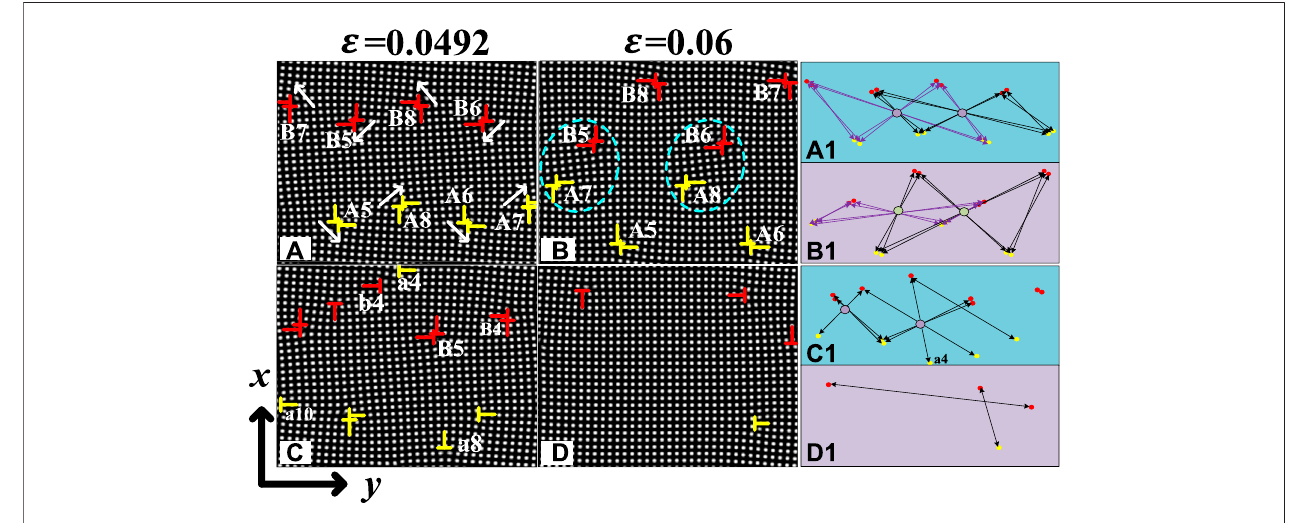
FIGURE4|(A – D) Thedislocation evolution of7 ° and6 ° andthecorrespondingstrainsareboth 0 . 0492and 0 . 06. (A1, B1),(C1,D1) Thearrangementof7 ° and6 ° with strains are both 0 . 0492 and 0 . 06.